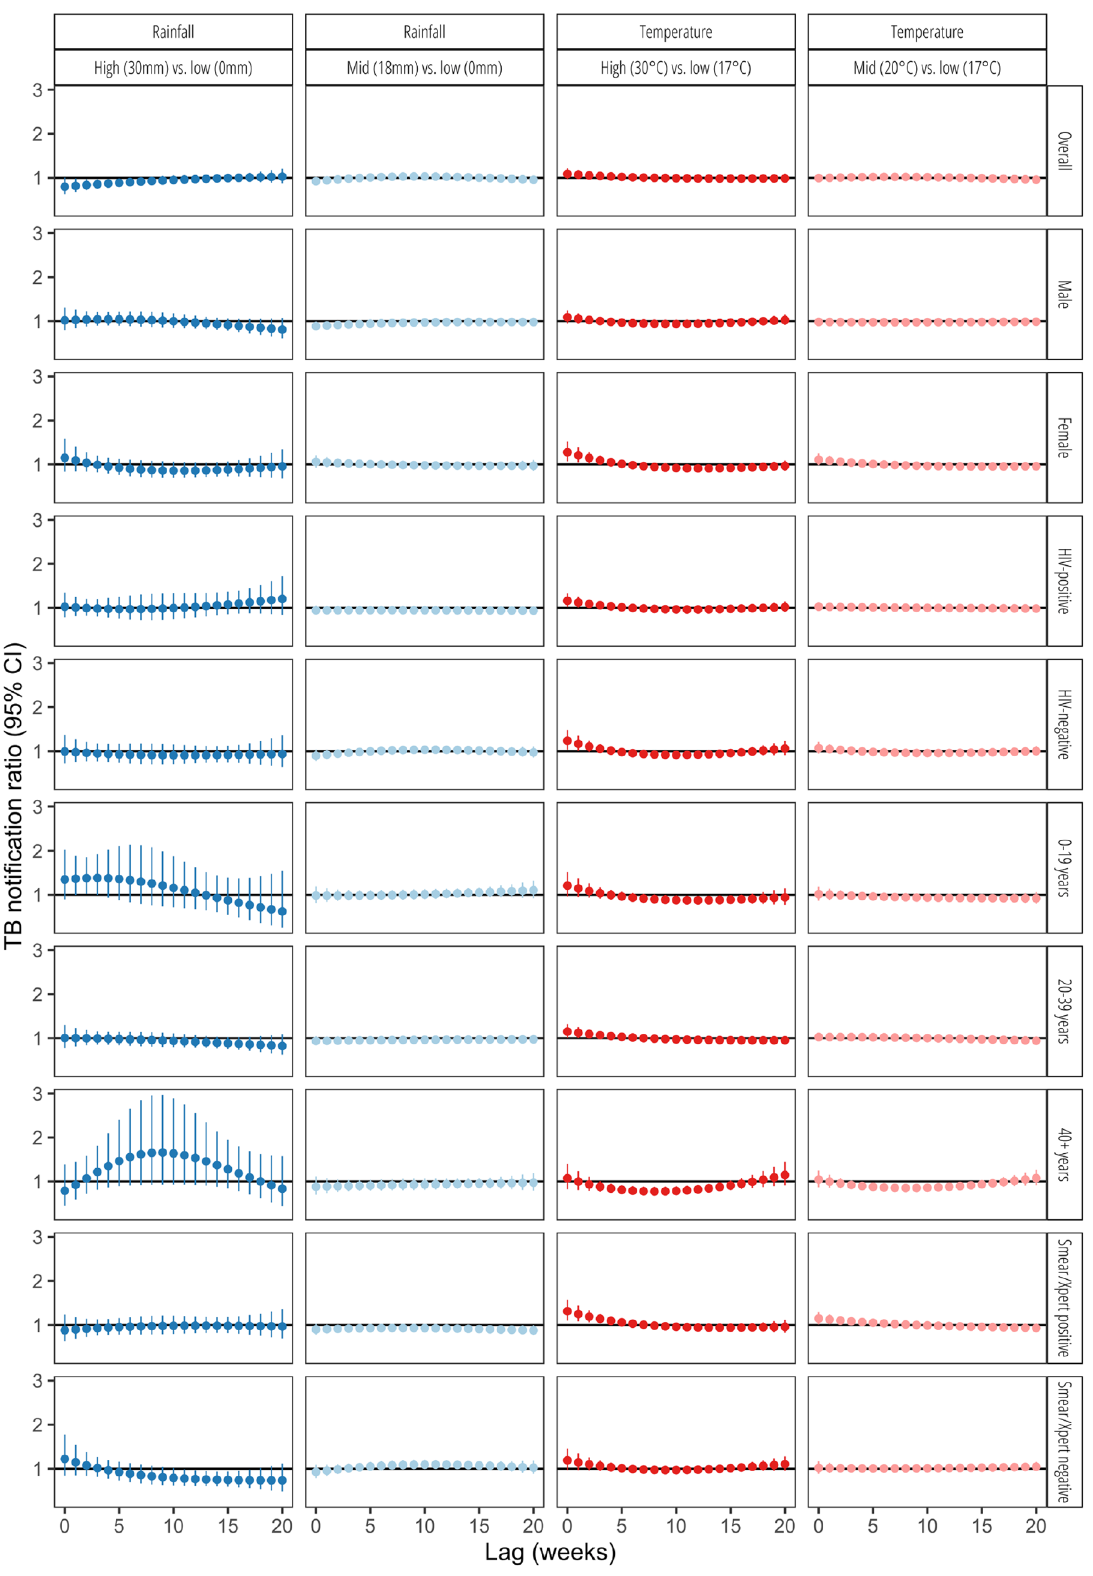
Figure 2. Associations between delayed TB case notifications and weekly lag in rainfall and